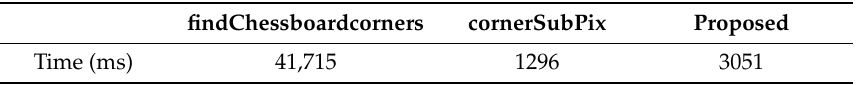
Table 4. Processing time of detecting 100 chessboard images for three different